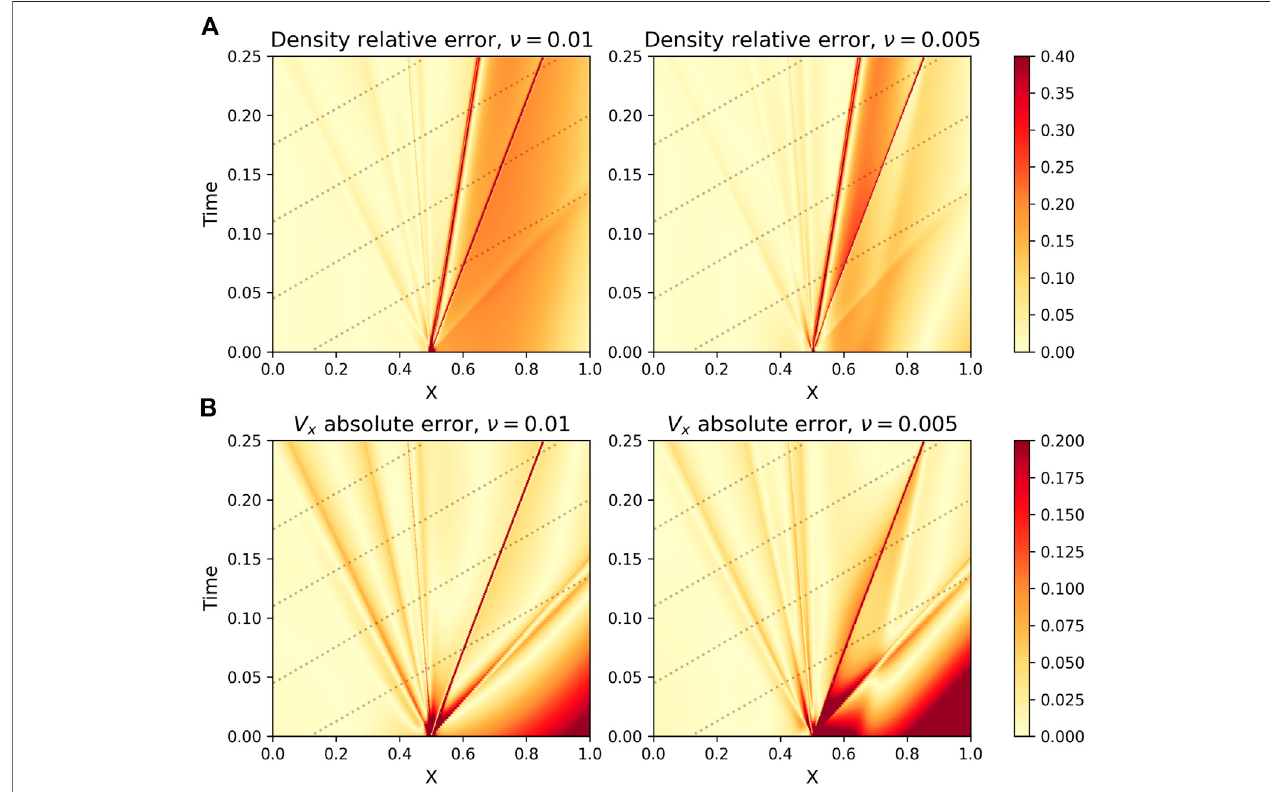
FIGURE8|(A) : DensityRelativeError (cid:3) ( ρ net − ρ )/ ρ (cid:3) fortwoPINNs( Left : ] (cid:1) 0.01; Right : ] (cid:1) 0.05)trainedwithfoursampledtrajectories(dottedlines)ontheBrio-Wu